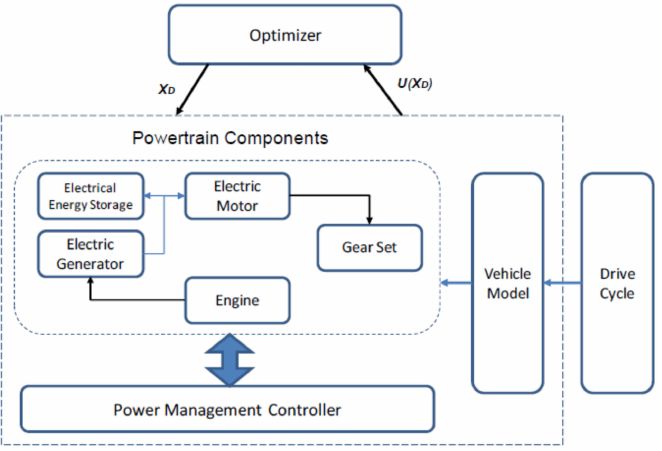
Figure 23. Case study one for the proposed optimizer [24].